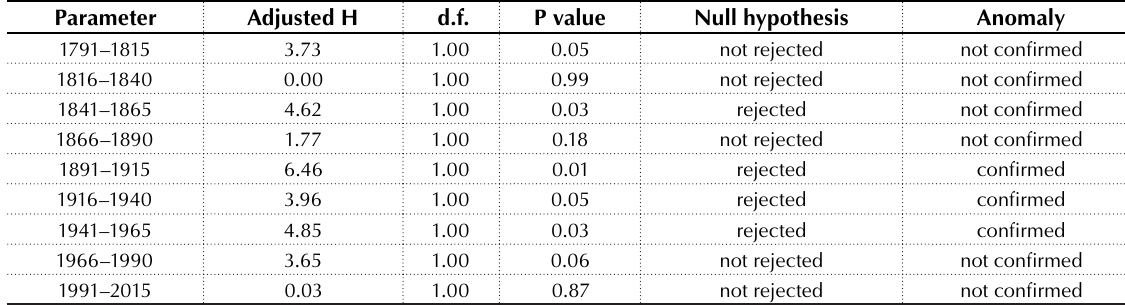
Table C 1. Kruskal-Wallis test of the January Effect for the US stock market during 1791–2015